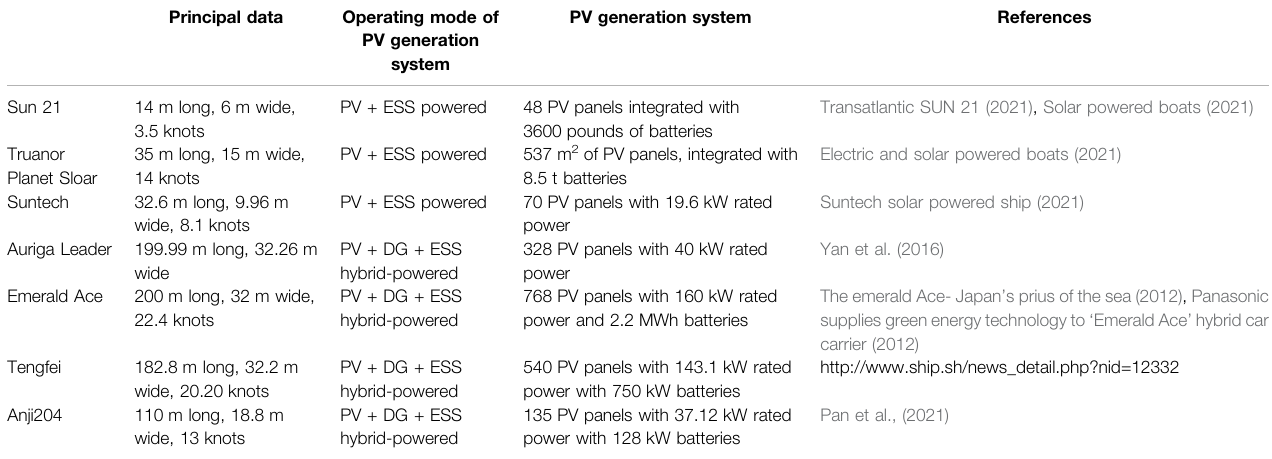
TABLE 1 | Representative solar-powered